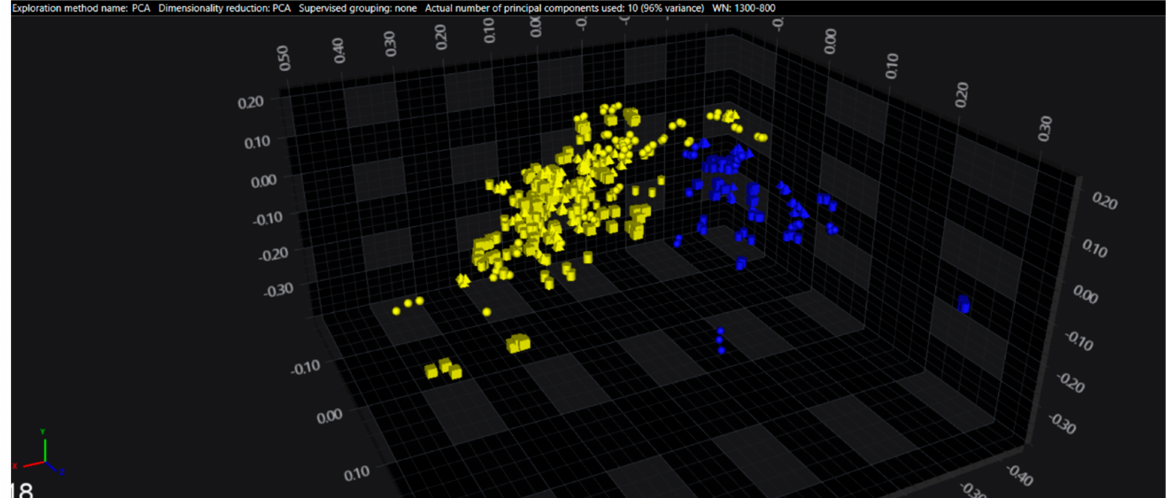
Figure 3. PCA of the O:7 serogroup (blue = Paratyphi C, yellow = other serovars).